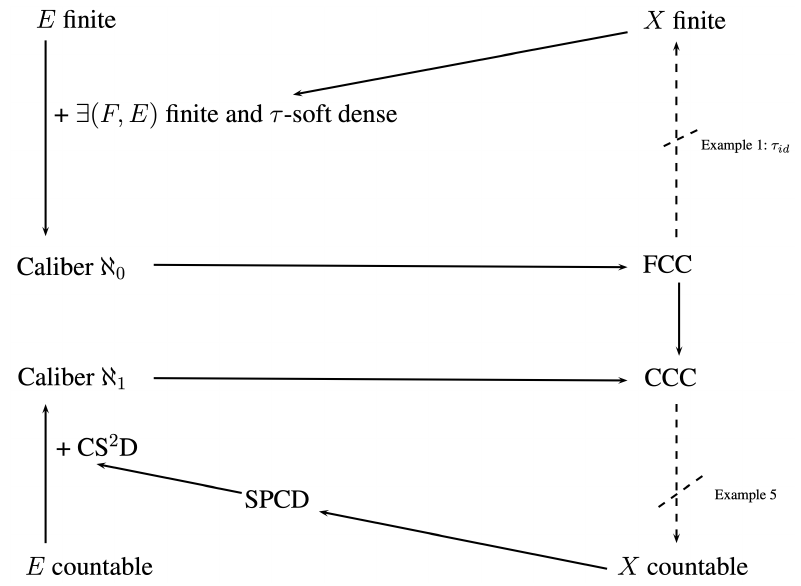
Figure 1. Summary of results about relationships among properties, and the role of